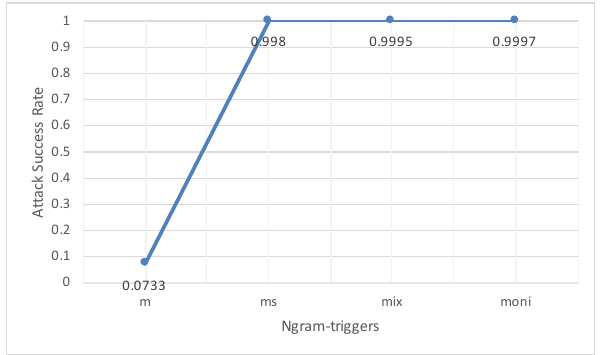
Figure 8. The trigger length evaluation of the